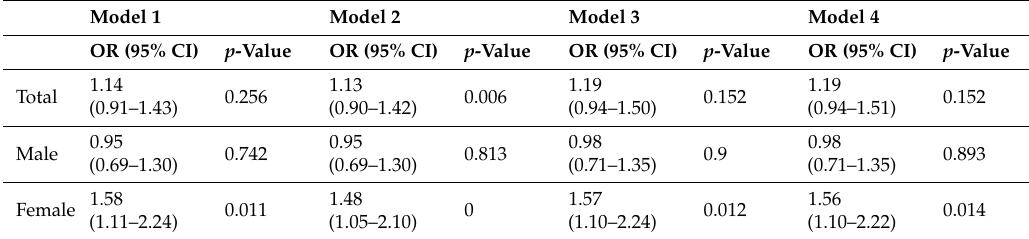
Table 4. Odds ratios (95% CI) of the prevalence of periodontitis according to work